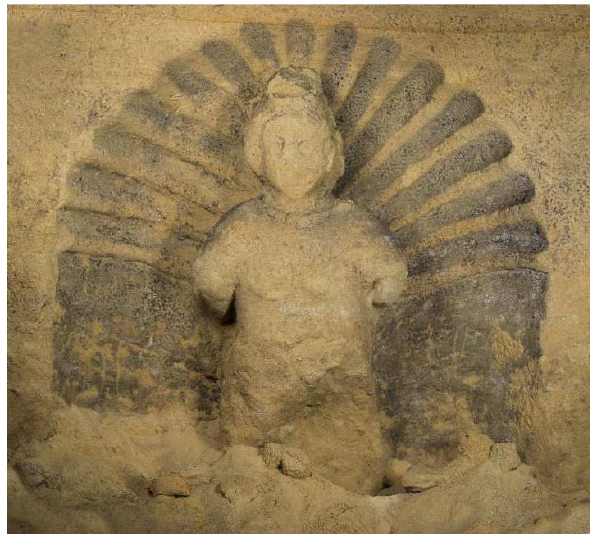
Figure 4: One of the statues contained in the recesses of the square room at the end of the first gallery.